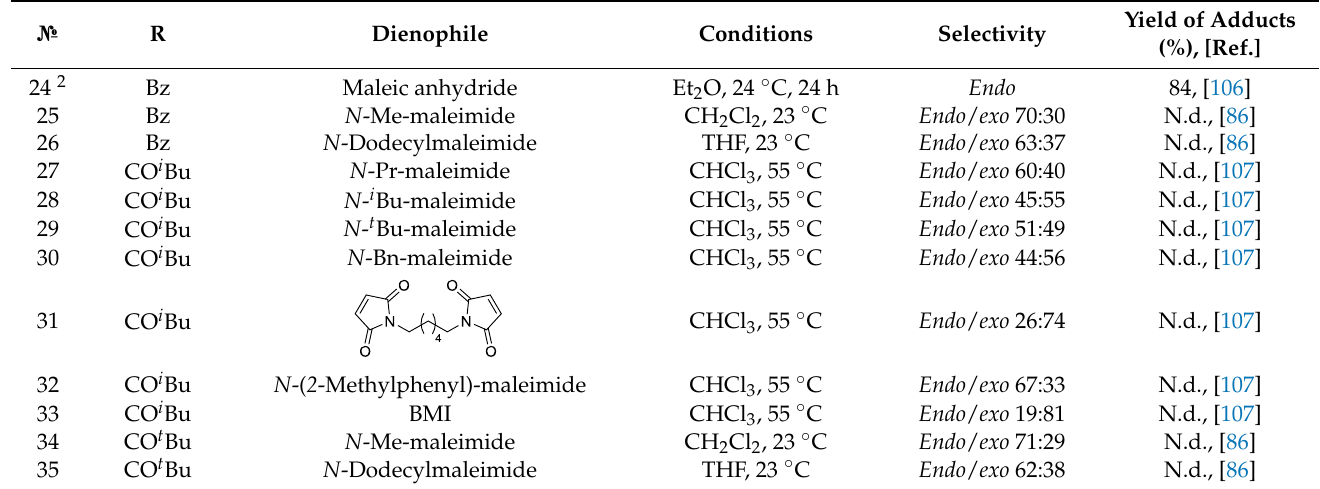
Information about the regio- and diastereoselectivity of functional FF derivatives with acyclic alkenes is scarce. A mixture of regio- and diastereoisomers with approximately equal distribution was detected after the noncatalytic reaction of FA with acrylonitrile (Table 4, entry 14). A mixture of regio- and diastereomers with ortho ( endo : exo )/ meta ( endo : exo ) 2:1/8:6 ratio was formed from itaconic anhydride reacting with FA acetate (Scheme 5) [85]. However, unfavorable thermodynamic parameters of cycloaddition with this dienophile were overcome using FA as a substrate, where proximal ( ortho ) DA adducts undergo further intramolecular cyclization, shifting the reaction equilibrium towards metastable lactone 5, which was isolated in 94% yield (Scheme 5) [85].